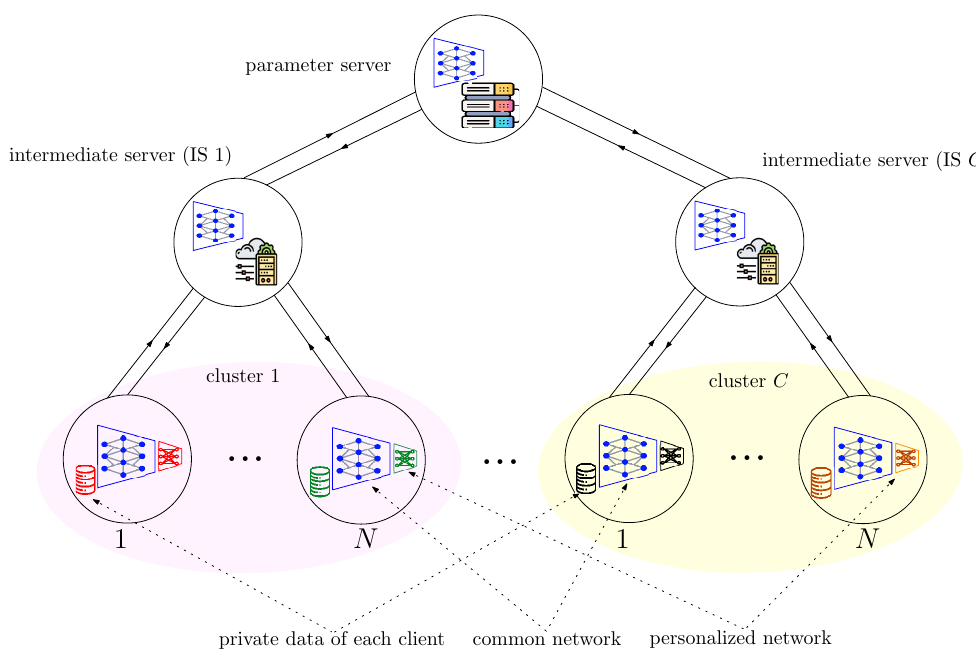
Figure 2. Hierarchical personalized federated learning (HPFL) framework with a common network (shown in blue) and small personalized headers (shown in red, green, black,